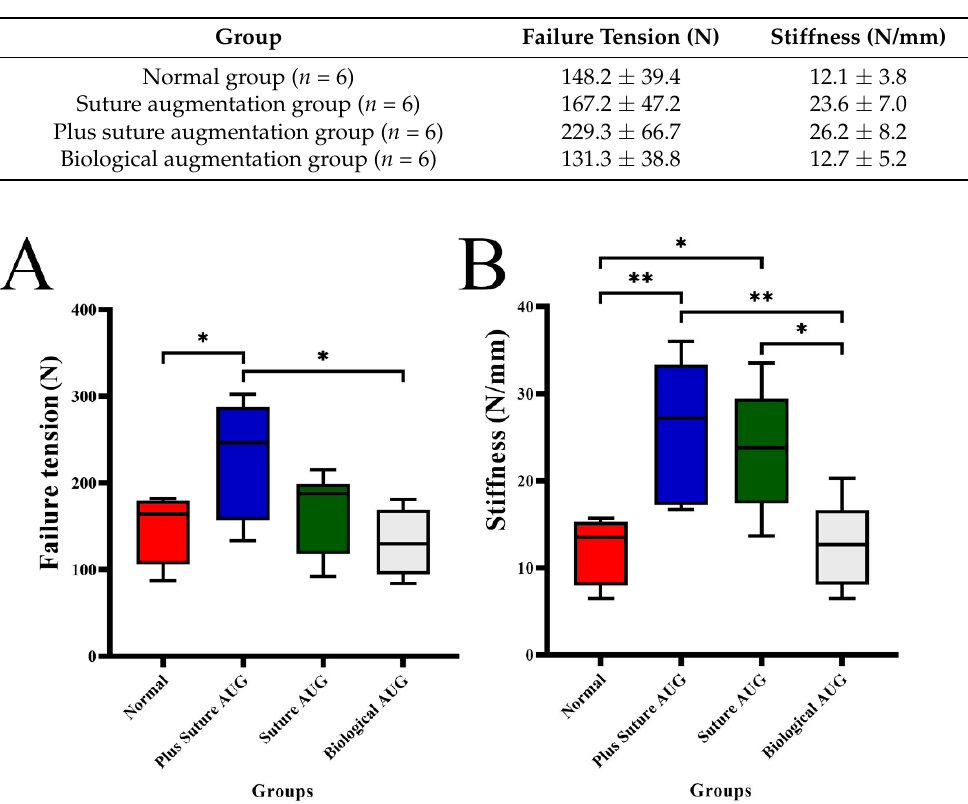
Figure 7. Comparison box diagram of failure tension and stiffness for four groups. The horizontal line represents the median, the box extends from the 25th percentile to the 75th percentile, and the bar represents the maximum and minimum of the observed value. ( A ) The box diagram of failure tension for four groups of ankle specimens. ( B ) The box diagram of stiffness for four groups of ankle specimens. * p ˂ 0.05; ** p ˂ 0.01.